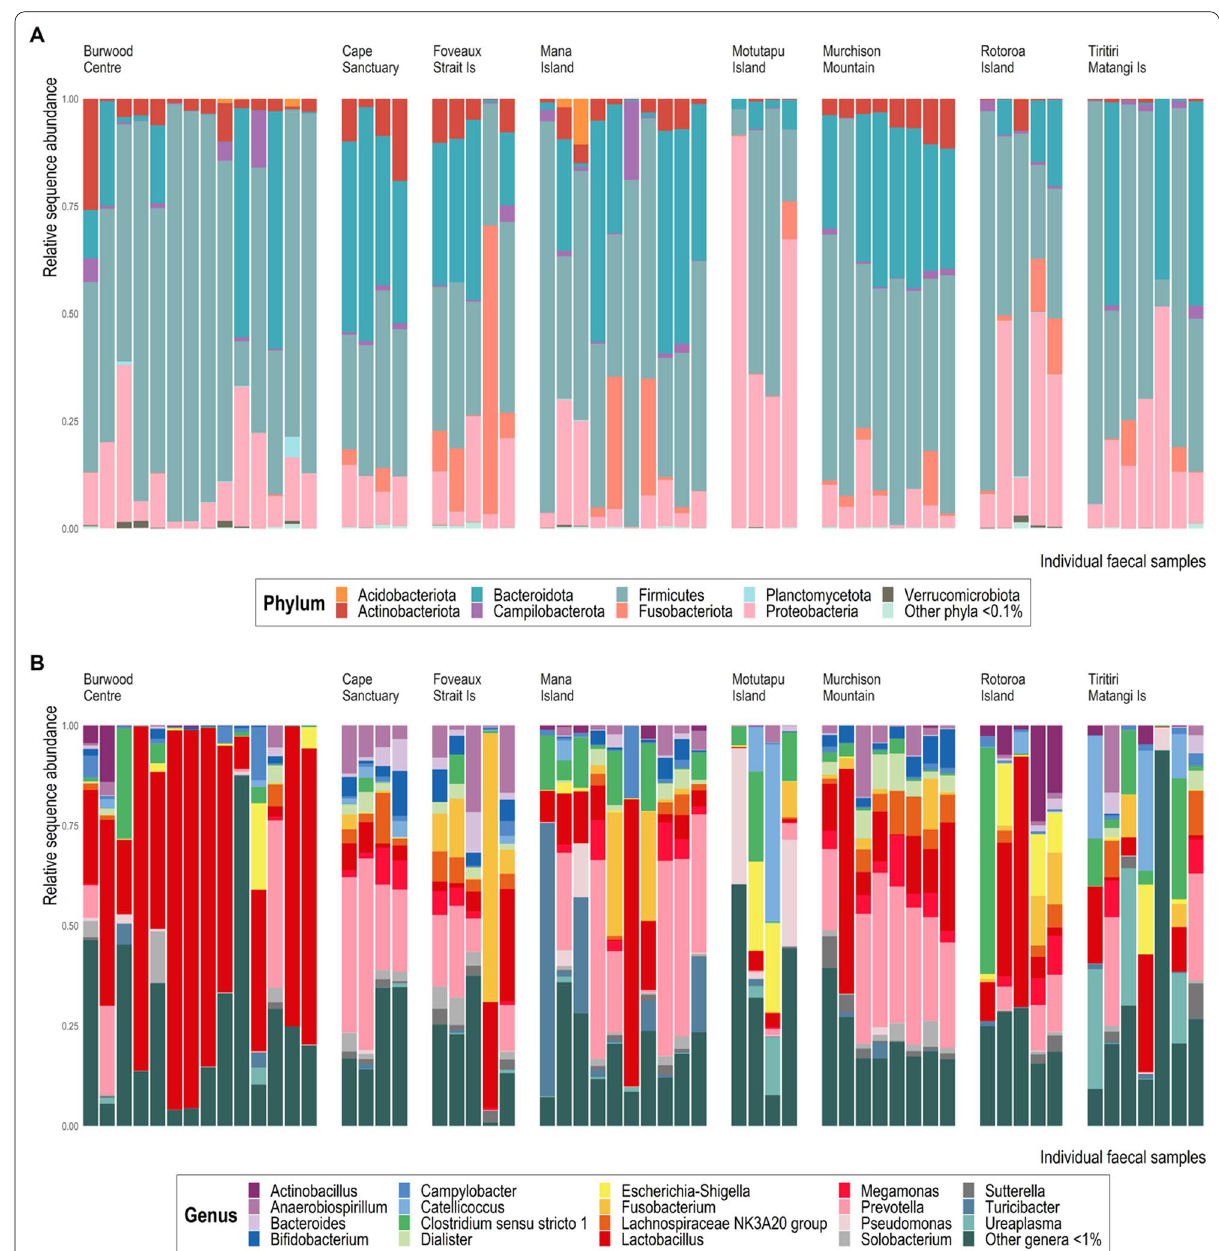
Fig. 1 16S rRNA gene-based taxonomic distribution of bacteria within takahē faecal samples at A phylum and B genus levels. Taxa with mean relative 16S rRNA gene sequence abundance < 0.1% and < 1%, respectively, are grouped together as ‘Others’. Each bar represents a single takahē faecal sample. Wild population Te Puhi-a-Noa Murchison Mountain, captive population Burwood Takahē Centre, insurance populations Cape = = = Sanctuary, Foveaux Strait island, Mana Island, Motutapu Island, Rotoroa Island and Tiritiri Matangi Island. No supplementary feed was provided to Te Puhi-a-Noa Murchison Mountain or Foveaux Strait Is